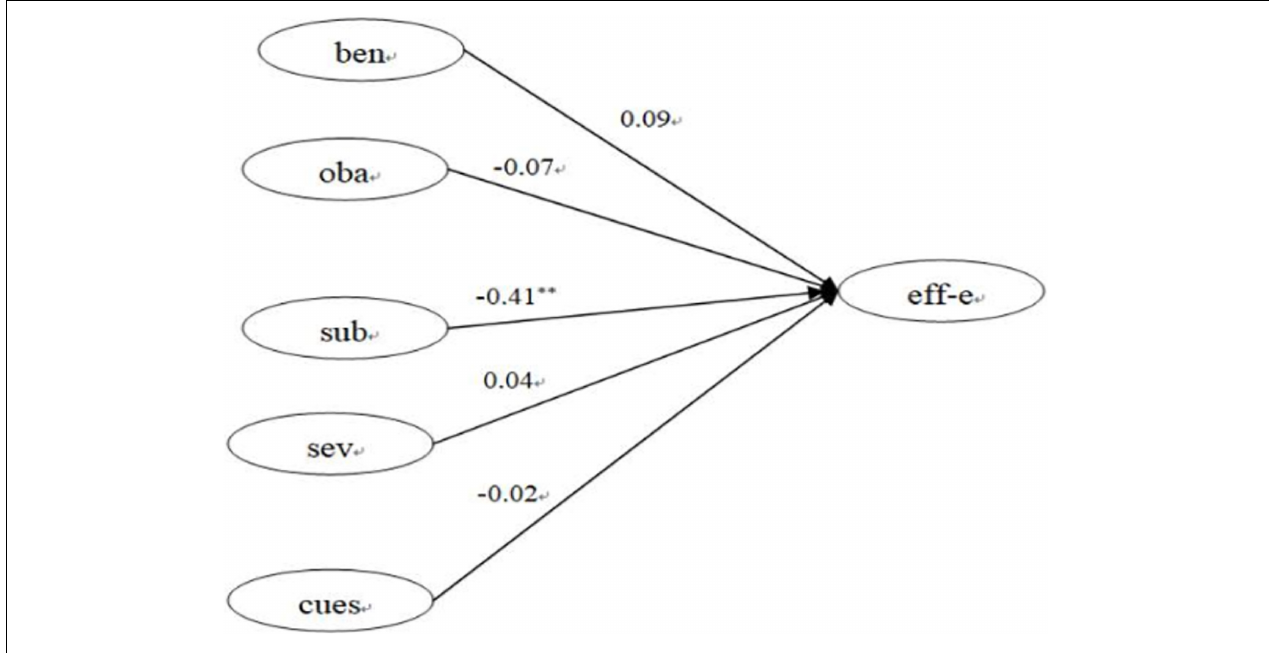
FIGURE 2 | The confirmatory factor analysis. Model—fit indices were statistically acceptable [CMID/DF = 2.781, RMSEA = 0.075, p = 0.001]. ben, perceived benefits; oba, perceived objective barriers; sub, perceived subjective barriers; sev, perceived severity; cues, cues to action; eff-f, self-efficacy of exercise. ∗∗ p <